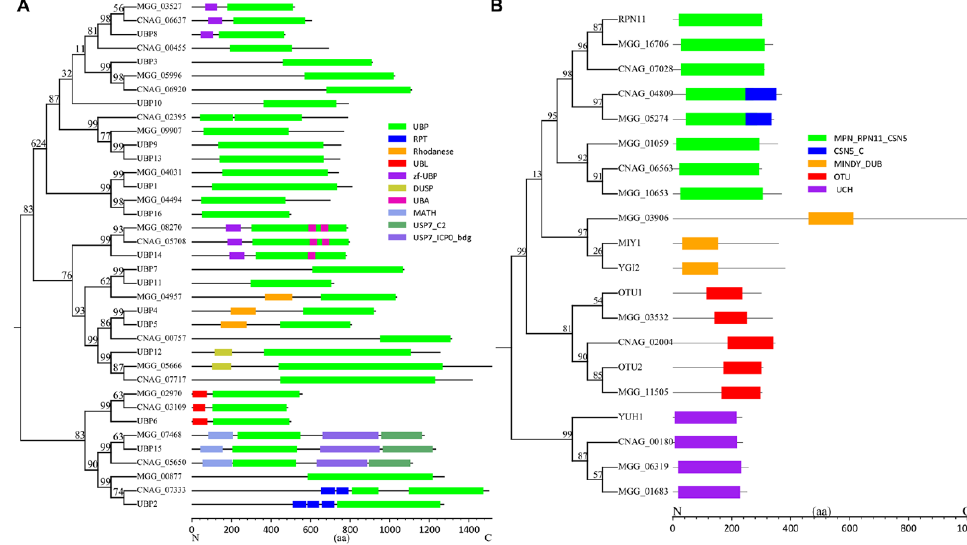
Figure 2. Phylogenetic tree and domain structure of DUBs in S. cerevisiae , C. neoformans, and M. oryzae : ( A ) Phylogenetic tree and domain structures of ubiquitin-specific proteases (UBPs) (zf-UBP, Zn-finger in ubiquitin-hydrolases and other protein; UBA, ubiquitin associated domain; RPT, repeated domain in UCH-protein; UBL, ubiquitin-like domain; DUSP, domain present in ubiquitin-specific protease; MATH, meprin and TRAF homology; USP7_C2, ubiquitin-specific protease C-terminal; USP7_ICP0_bdg, ICP0-binding domain of ubiquitin-specific protease 7); ( B ) phylogenetic tree and domain structures of UCHs, OTUs, MINDY, and JAMM family proteins. The domain architectures of DUBs are drawn by referring to predicted results from databases of Pfam, PROSITE, SMART, and Interpro.